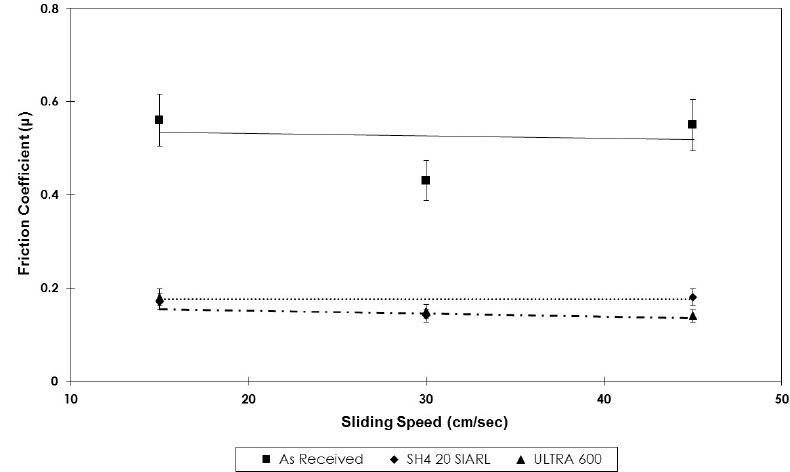
Figure 4. Effect of sliding speed on the friction coefficient of multilayered polymeric coatings and bare soda ‐ lime glass against stainless steel